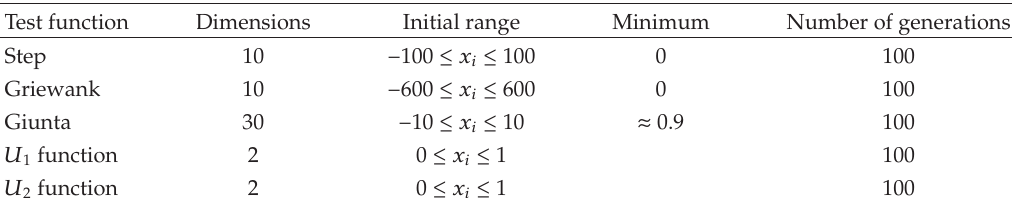
Table 1: Parameters for five functions.